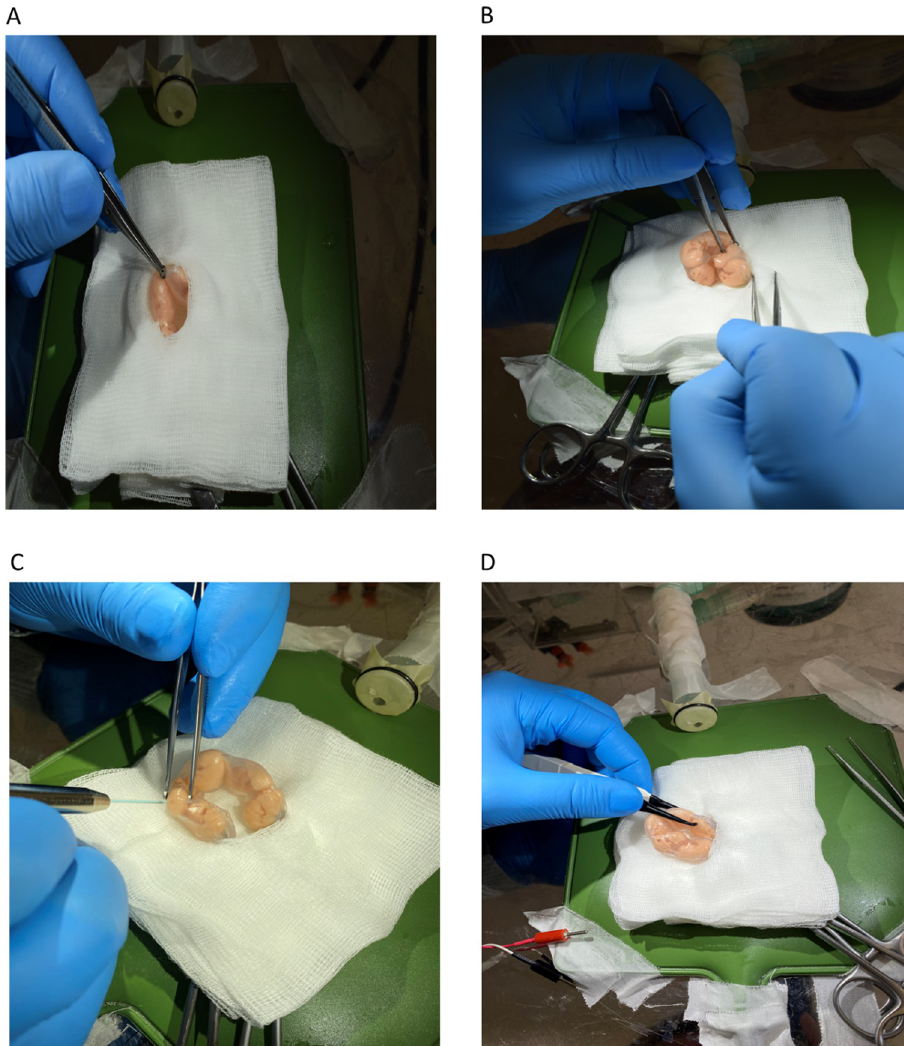
Fig 5. Simulation of in utero electroporation (IUE). (A) Opening of the mouse abdominal cavity. (B) Handling of embryos outside of the abdominal cavity. (C) Injection of the DNA-containing solution in the lateral ventricle. (D) Application of voltage through forceps-type platinum